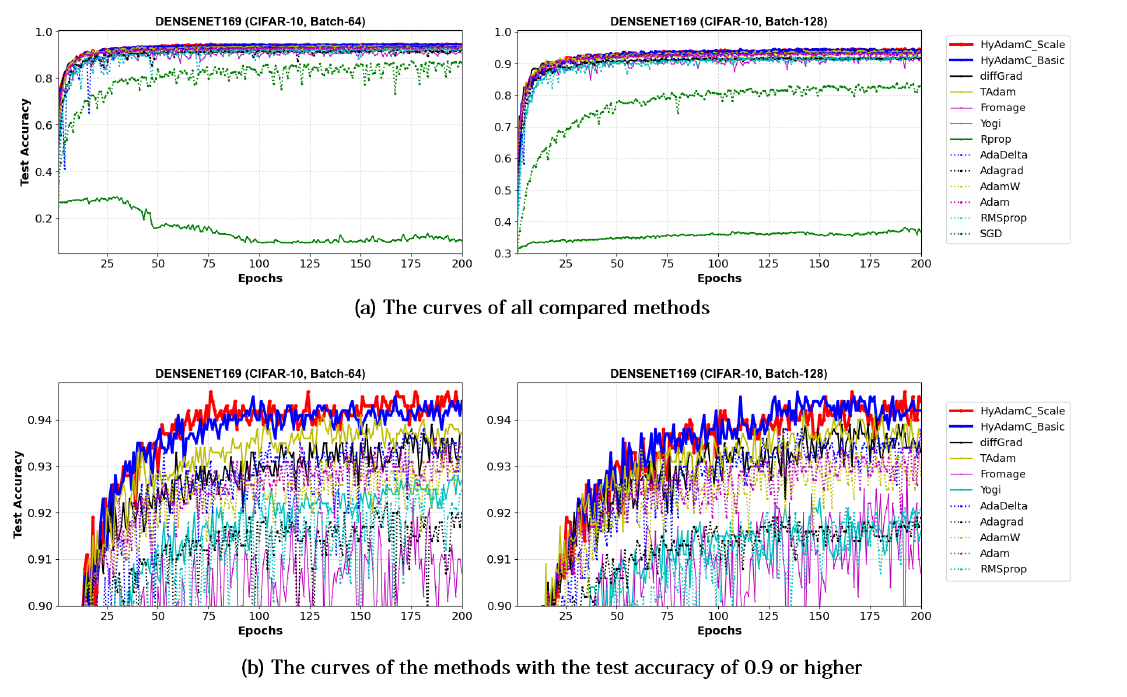
Figure 24. The test accuracy curves of the DenseNet-169 trained by HyAdamC and other optimization methods in the CIFAR-10 image classification tasks. In this figure, ( a ) shows the test accuracy curves of all compared methods. On the other hand, ( b ) illustrates the plots in which a range of the y-axis of the plots described in ( a ) is zoomed into between 0.9 and